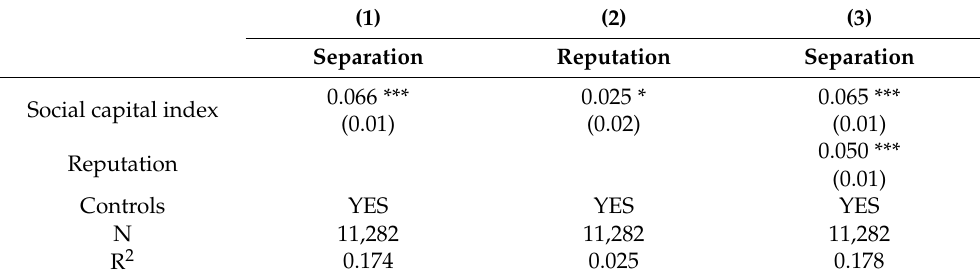
Table 8. Mediating effect of